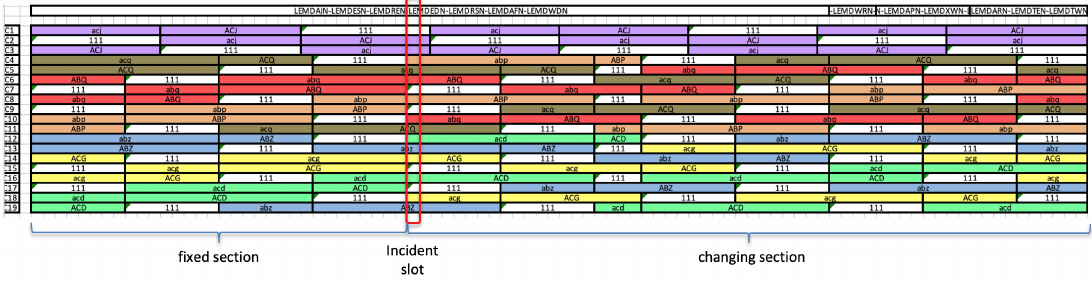
Figure 2. Solution matrix with an incident